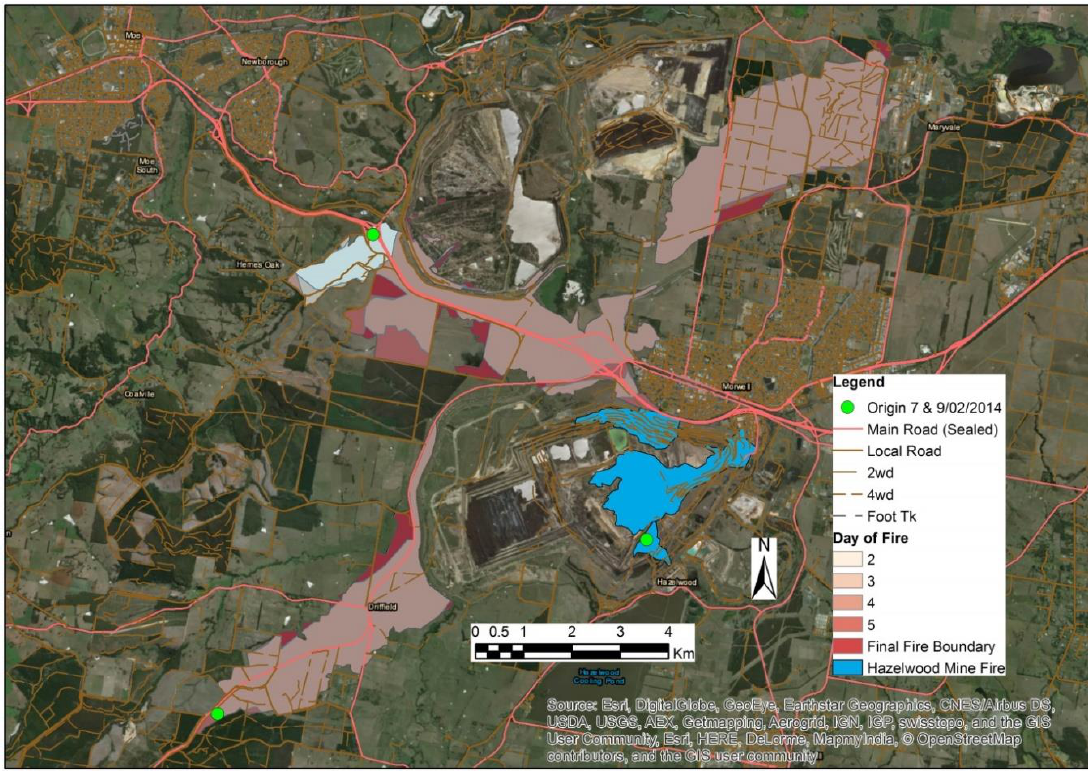
Figure A5. Morwell fire progression map.